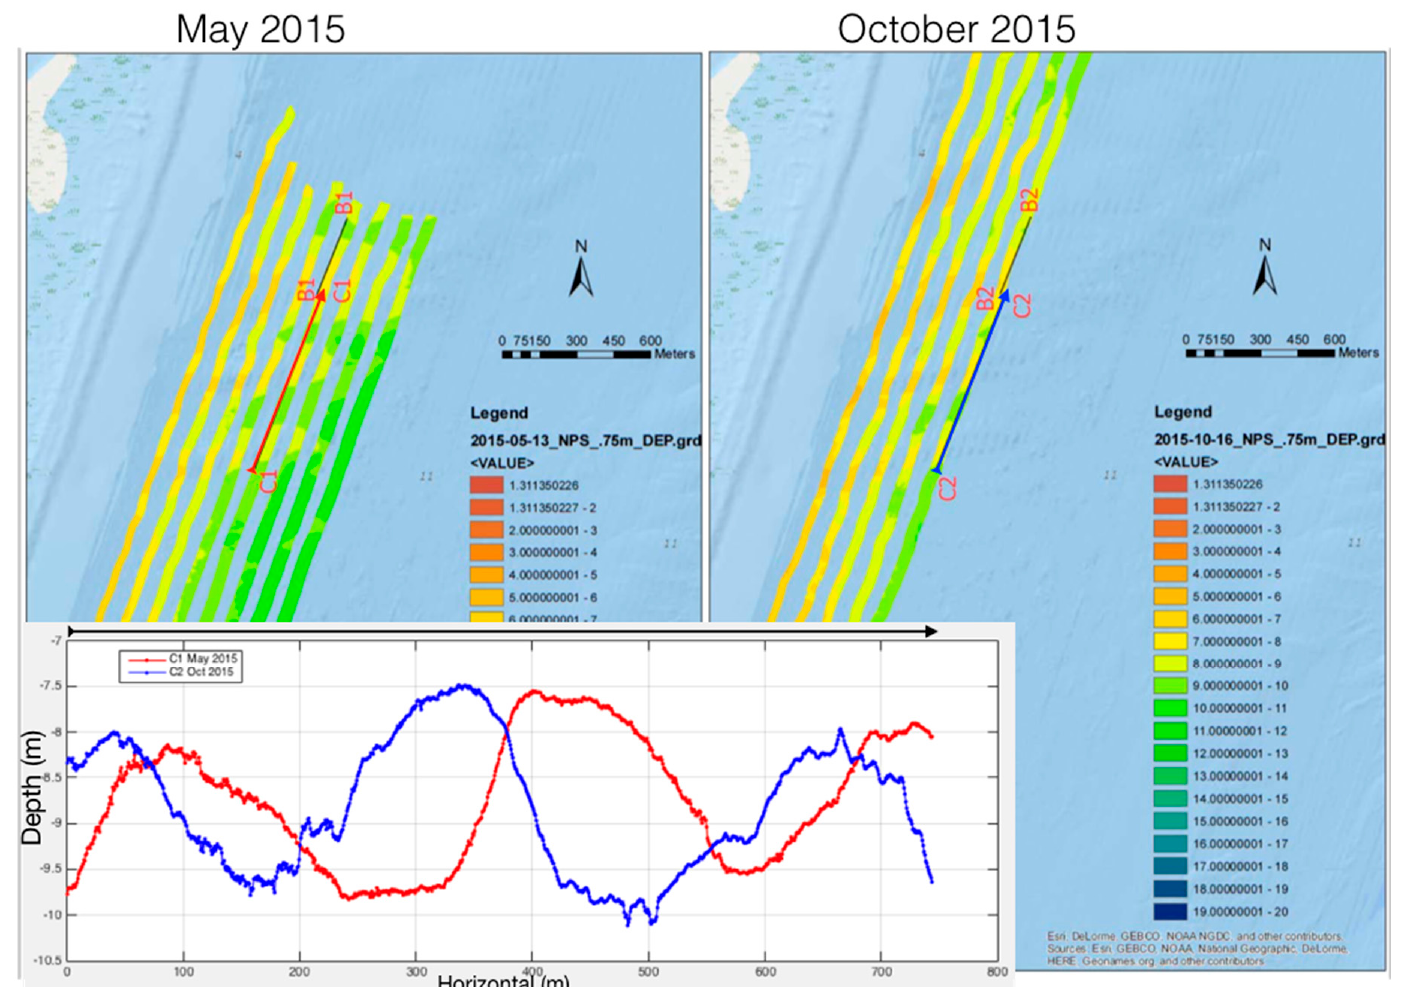
Figure 23. Bathymetry profile change after Hurricane Joaquin. Red curved line represents the bathymetry profile G1 in May 2015 and blue curved line represents the bathymetry profile G2 in October 2015. Please note the change in surface roughness and the vertical offset in the bathymetry.